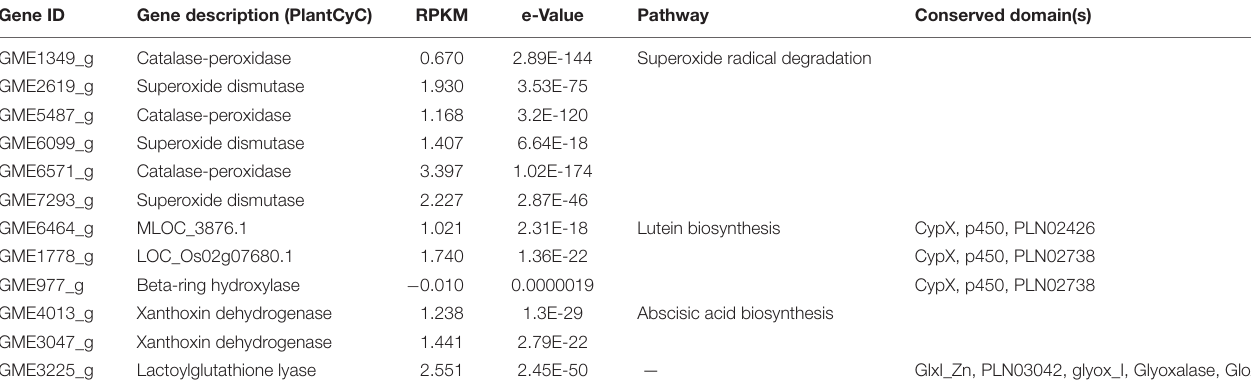
TABLE 1 | List of notable genes in L. rhinoceros